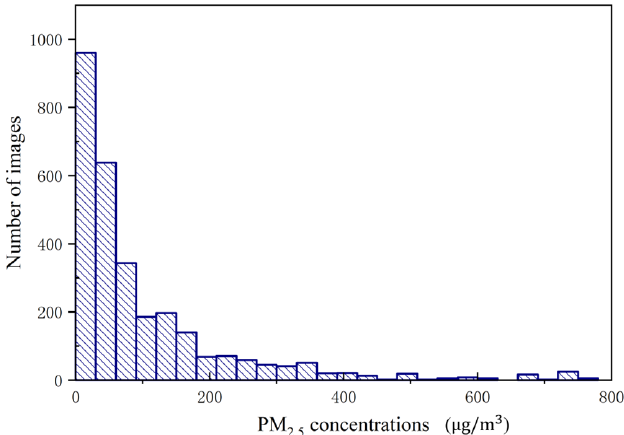
Figure 2. Number of smartphone photographs taken at different levels of PM 2.5 concentration as measured by the “Nature Clean” monitor for the PhotoPM-daytime dataset.